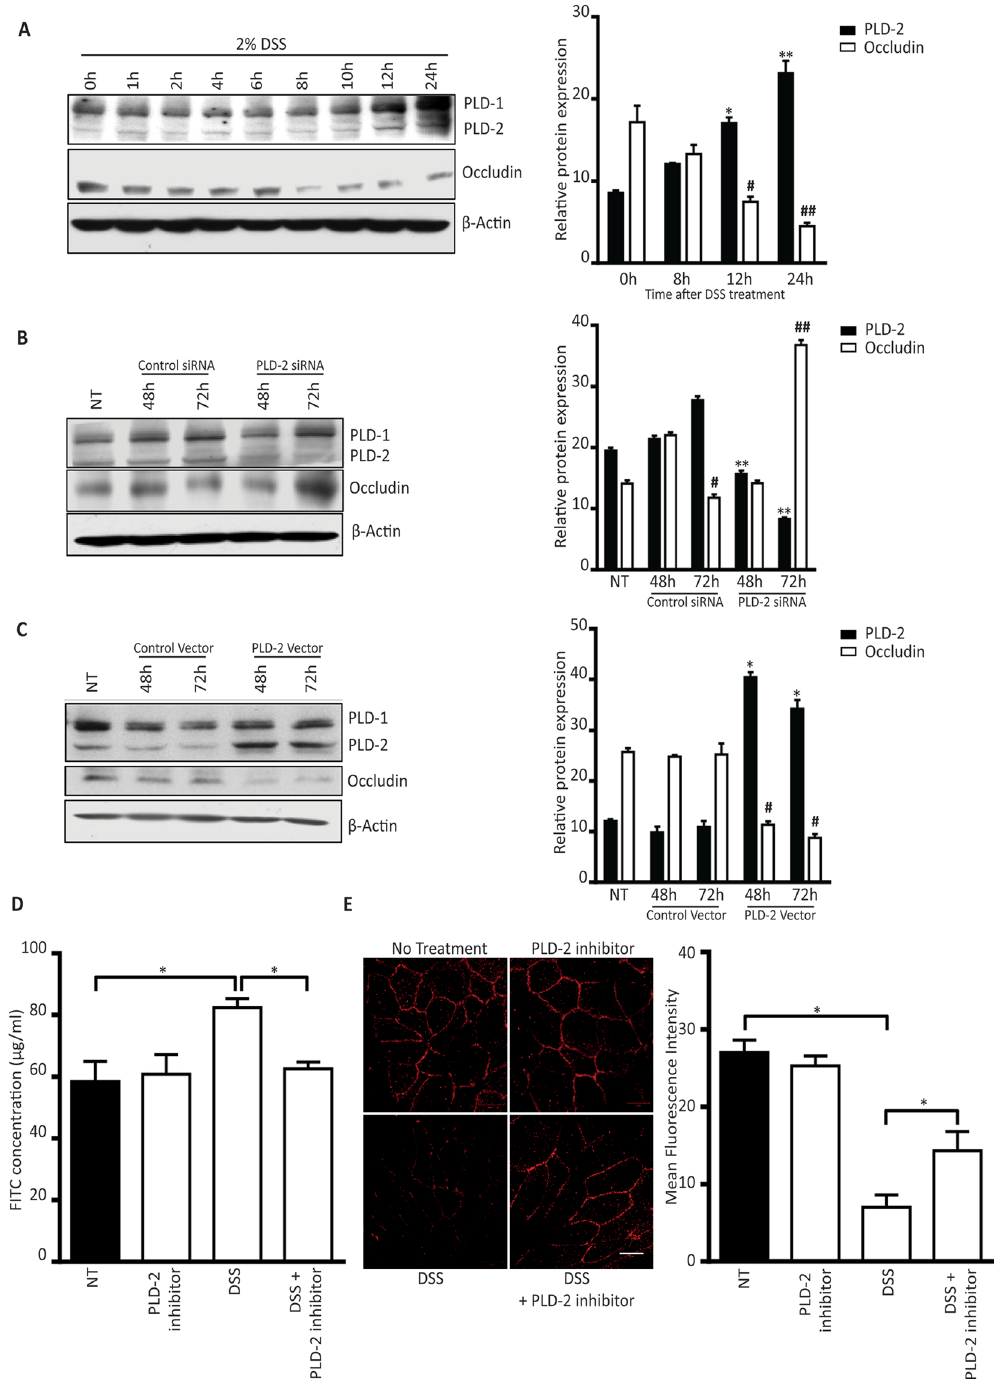
Figure 4. PLD2 is involved in DSS-induced downregulation of occludin. ( A ) Western blots showing the effect of DSS treatment on the level of PLD2 in HT-29 colon epithelial cells at the indicated time points. Quantitative data showing the relative PLD2 and occludin expression at 8, 12, and 24 hours. ( B ) Effects of siRNA-mediated PLD2 knockdown in HT-29 colon epithelial cells ( C ) HT-29 colon epithelial cells were transfected with control, or PLD2 vector and PLD2, and occludin expression was analysed at 48 and 72 hours. Graph showing relative protein expression. Panel A–C: PLD2 expression of untreated (NT) vs. the indicated time point, or specified treatment group ( * p < 0.05, ** p < 0.01); occludin expression in NT vs. the indicated time point or specified treatment group ( # p < 0.05, ## p < 0.01). Uncropped western images are shown in the Supplementary Fig. S6. ( D ) In-vitro intestinal permeability assay using Caco-2 monolayer culture. Data are represented as the concentration of FITC in μ g/ml. ( E ) Immunocytochemistry assessing the expression of occludin in a confluent Caco-2 monolayer culture treated with DSS, or DSS + PLD2 inhibitor. Scale bar is 10 µ m. Bar graph shows the mean fluorescence intensity. All data are represented as the mean ± SEM. * p <